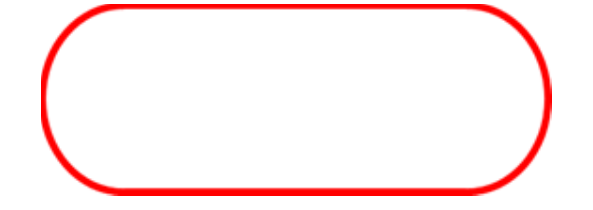
Figure 1. A sketch of ear-shape SFT structure.